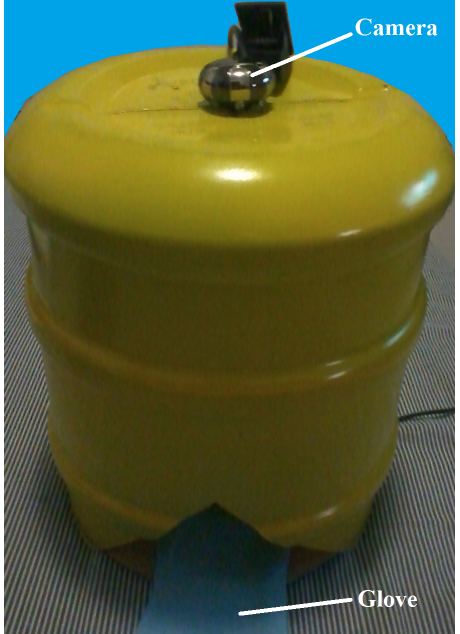
Fig. 5: Materials used to create the controller. The 20 L mineral water bottle was painted so it could block any outside incoming light.